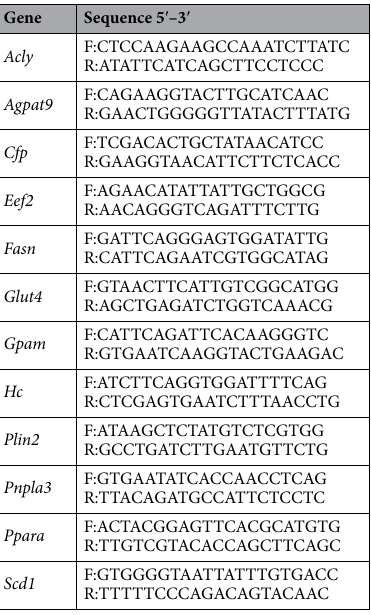
Table 1. The sequences of forward (F) and reverse (R) primers used in